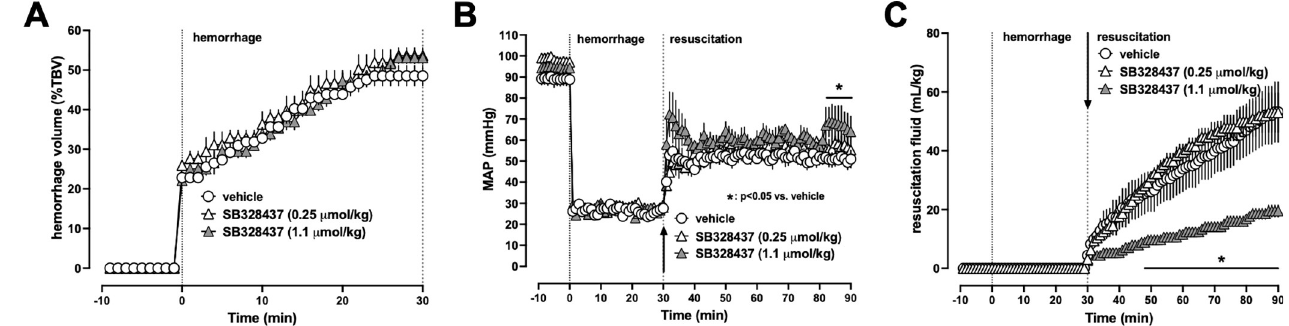
Fig 1. Single dose SB328437 treatment reduces fluid resuscitation requirements after 30 min of hemorrhagic shock. All data are mean ± SE. Arrows represent the time point of drug/vehicle injection. Open circles: animals treated with vehicle (n = 5). Open triangles: animals treated with 0.25 μ mol/kg SB328437 (n = 3). Grey triangles: animals treated with 1.1 μ mol/kg SB328437 (n = 3). * : p < 0.05 vs. animals treated with vehicle. (A) Hemorrhage volumes for maintain mean arterial blood pressure (MAP of 30 mmHg). %TBV: percent of total blood volume. (B) MAP (mmHg) (C) Fluid resuscitation in mL/kg required to maintain MAP of 60 mmHg or systolic blood pressure (SBP) of 90